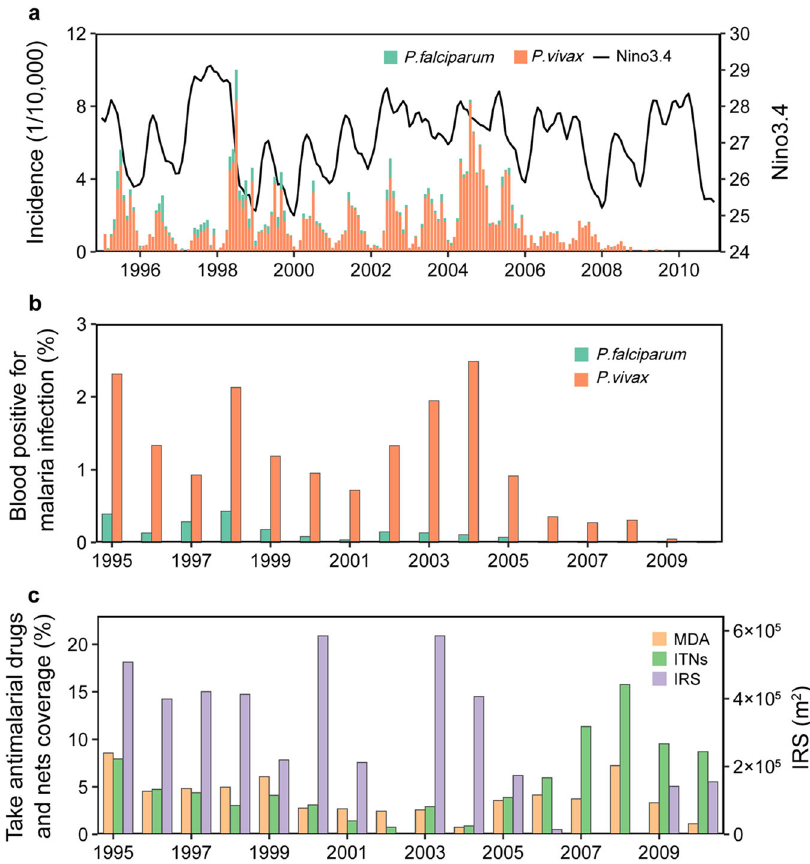
Fig. 1 Summary of the Qiongzhong highland malaria epidemic between 1995 and the elimination of endemic malaria in 2010. a Monthly incidence of Plasmodium vivax (orange) and Plasmodium falciparum (green) and the Niño 3.4 index (black line). The Niño 3.4 index uses a 5-month running mean. b The changes in malaria prevalence in the population measured using an annual blood examination. c Malaria control strategy used in the study area. Antimalarial drug campaigns (orange), area of indoor spraying with the pesticide dicophane (DTT) (purple), and use of deltamethrin-treated nets (green). IRS, indoor residual spraying. ITNs, insecticide-treated bed nets. MDA, mass antimalarial drug administration.